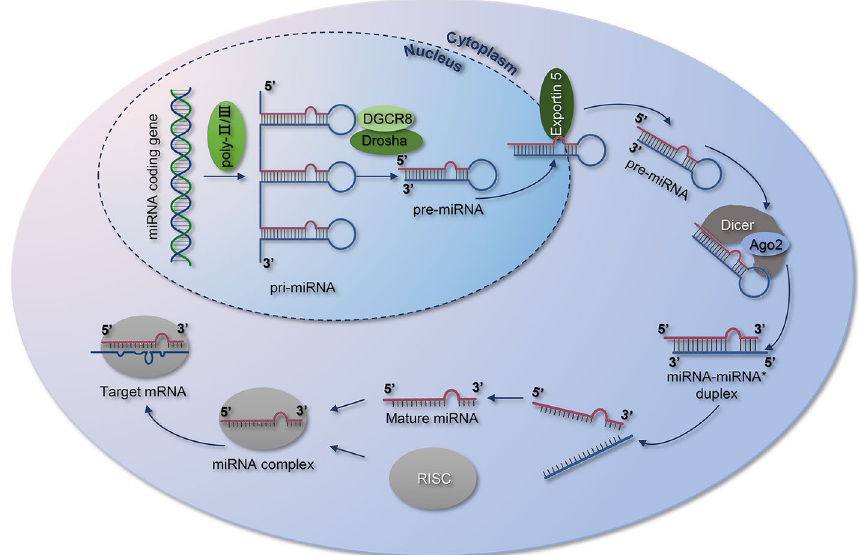
Fig. 1 The biosynthesis process of microRNAs. This multistep maturation process includes the production of the pri-miRNA transcript by RNA Pol II&III and cleavage of the pri-miRNA by the microprocessor complex (Drosha and DGCR8) in the nucleus. The resulting pre-miRNAs are exported from the nucleus via Exportin-5. In the cytoplasm, the RNase Dicer forms a complex and cleaves the pre-miRNA hairpin to its mature length. The functional strand of the mature miRNA is combined with Ago2 into the RISC, where it guides it to induce silencing of target mRNAs through mRNA cleavage, translational repression, or